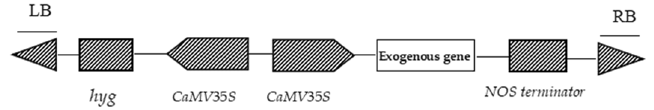
Figure 1. Diagram of the pCAMBIA1302 overexpression